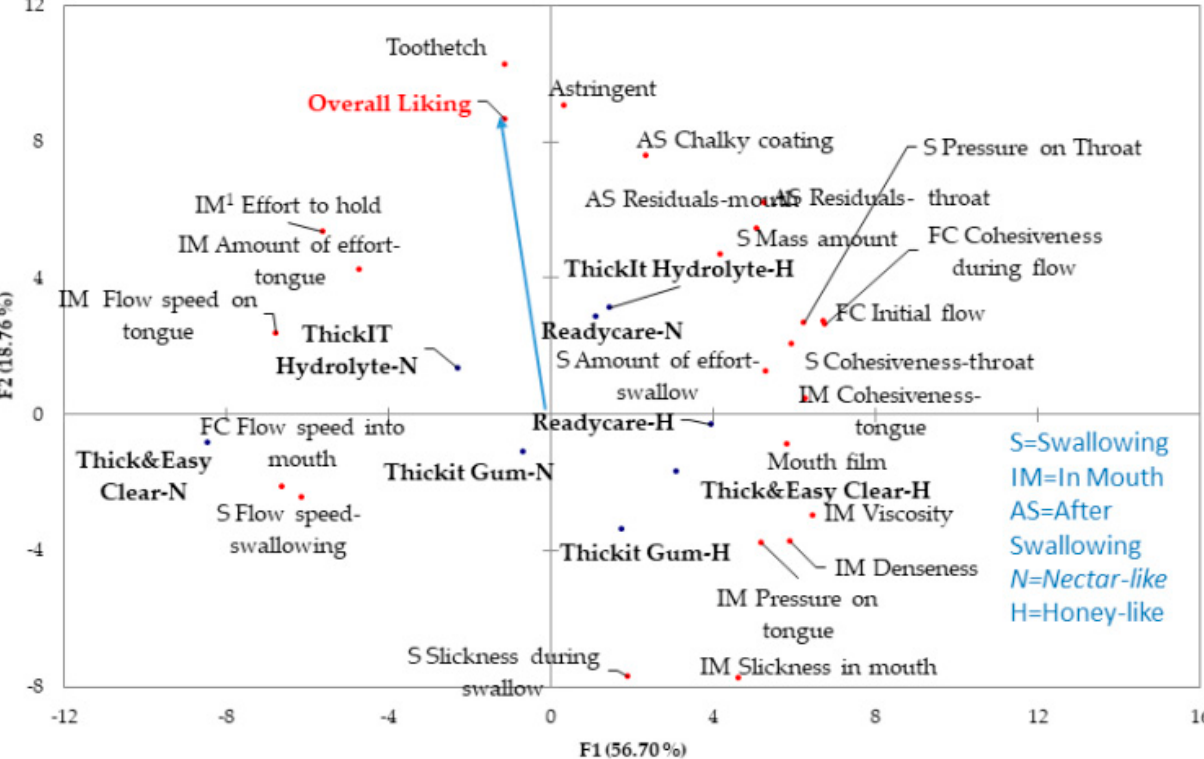
Figure 3. External preference mapping (texture) FC = From Cup.